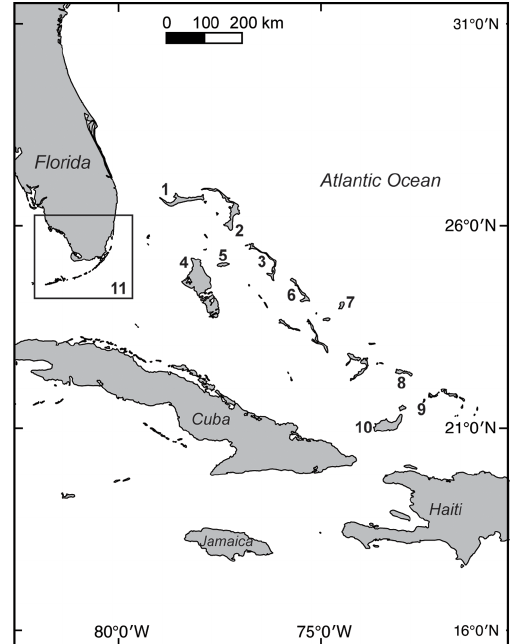
Figure 1. Map of region considered in this data compilation, in- cluding the Bahamas, Turks and Caicos, and the east (Atlantic) coast of Florida. Site numbers are as follows: (1) Grand Bahama; (2) Abaco; (3) Eleuthera; (4) Andros; (5) New Providence; (6) Exu- mas; (7) San Salvador; (8) Mayaguana; (9) West Caicos; (10) Great Inagua; (11) southeast Florida